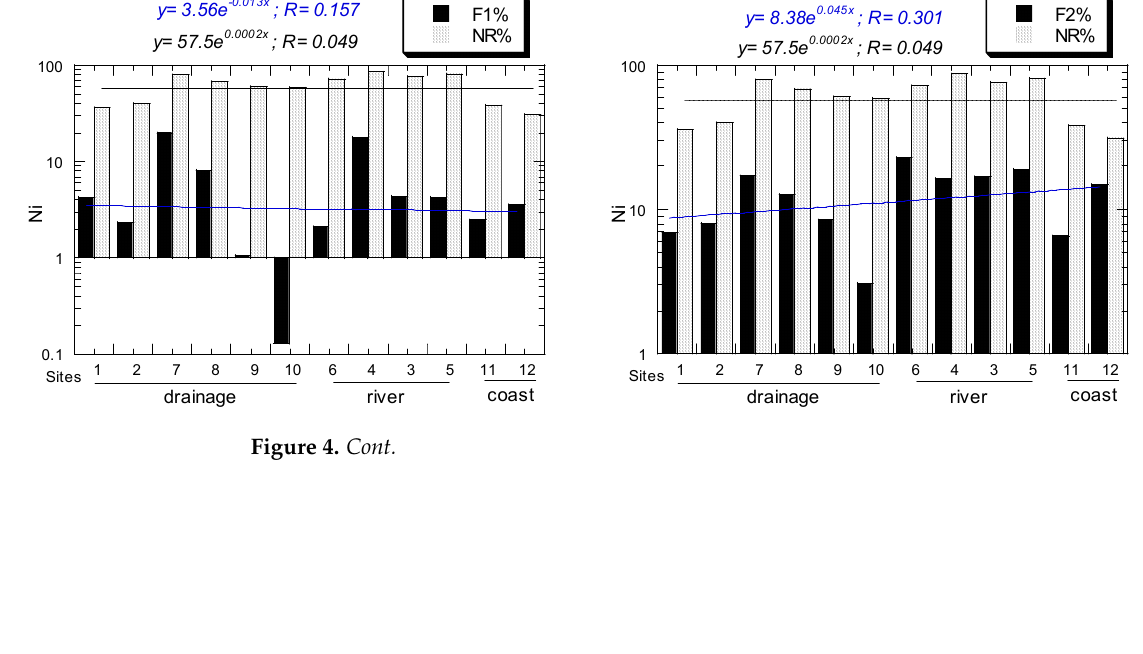
For Ni, all NR/R ratios of all sites ranged from 0.45 to 3.94. For Ni, all EF values of all